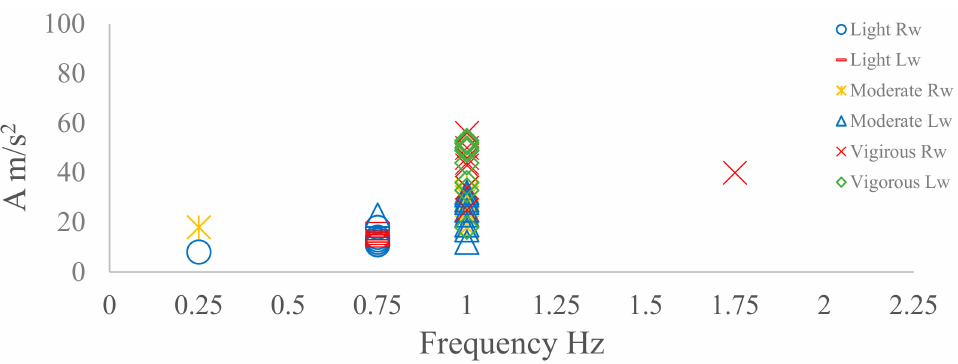
Figure 6. Right and left wrist dominant frequency and amplitude for di ff erent walking